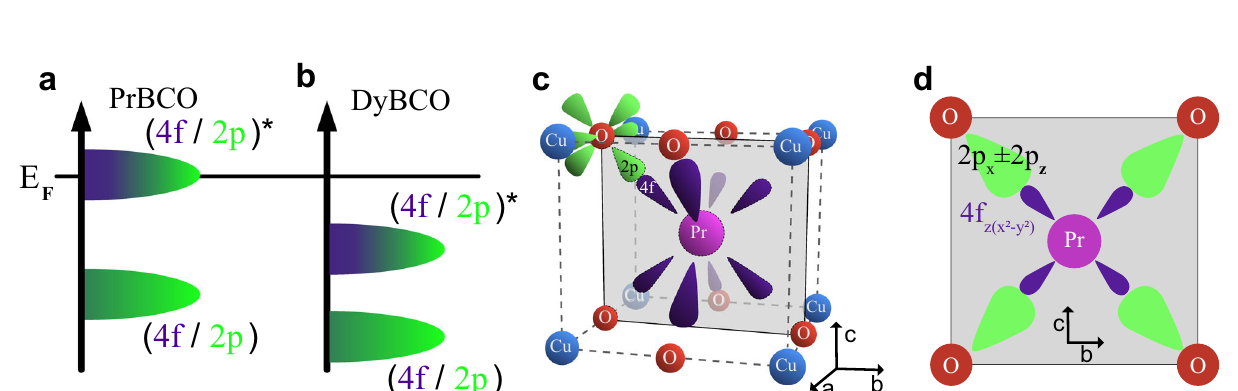
Fig. 3 | The nature of the 3D CO. a The x-ray absorption spectrum (XAS) (gray) showsthe Cu L 3 edge withashoulderatlowerenergiescorresponding to thePr M 5 edge. The two dipole-allowed transitions are labeled as insets. The purple data show the energy dependence of the scattered intensity of the 3D CO at T c =50K withthetwomostprominentfeatureslabeledaspeaksAandB. b Asemi-logplotof rocking curve scans of the 3D CO peak taken on resonance (930.3 eV) and well